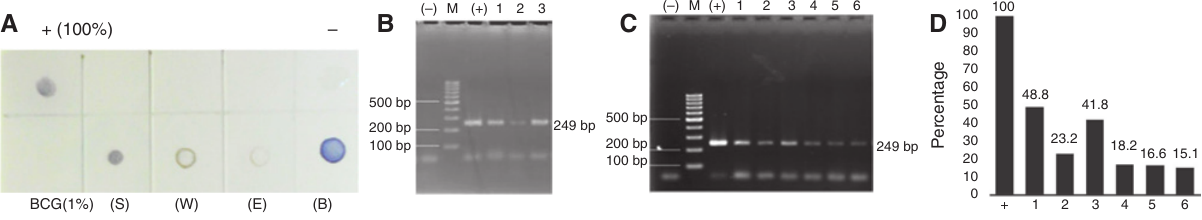
Figure 2: (A) The efficiency of crosslinking reaction. BCG: the remaining BCG after enrichment reaction; (S): the supernatant discarded after incubation particles with second antibody; (W): the supernatant discarded after wash particles with PBS; (E): the equilibrate solution; (B) the solution obtained after incubating particles with NBT/BCIP (Approximate placement after the first paragraph of the section 2 Single and dual complexes formation and specific mycobacterial cell lysis efficiency, result section). (B) Single-complex activities. (–): M; ( + ): negative control, 100-bp marker, and positive control. Lane 1: MTB was captured by the NP-NH -anti-TB antibody complex and lysis by heating in 2 100 ° C. Lanes 2 and 3: M. bovis in BCG vaccine lysis by NP-NH -lipase and NP-NH -lysozyme complex, respectively. (C) Dual-complex activi- 2 2 ties. (–): M; ( + ): negative control, 100-bp marker, and positive control. Lanes 1 and 2: Complexes were generated by the one-step coupling reaction of antibody and enzymes (lysozyme and lipase, respectively) to nanoparticle. Lanes 3 and 4: Complexes were generated by two continuous steps of the coupling antibody to the nanoparticles and then coupling enzymes (lysozyme and lipase, respectively). Lanes 5 and 6: Similar to lanes 3 and 4, but the reaction started with coupling enzymes (lysozyme and lipase, respectively) and then coupling antibody to the nanoparticles. (D) ImageJ analysis. The intensity of DNA band in lane ( + ); 1 to 6 in (C),